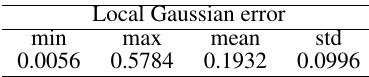
Table 5. Statistics of the variation of camera distortion correction. The results are expressed in pixel.